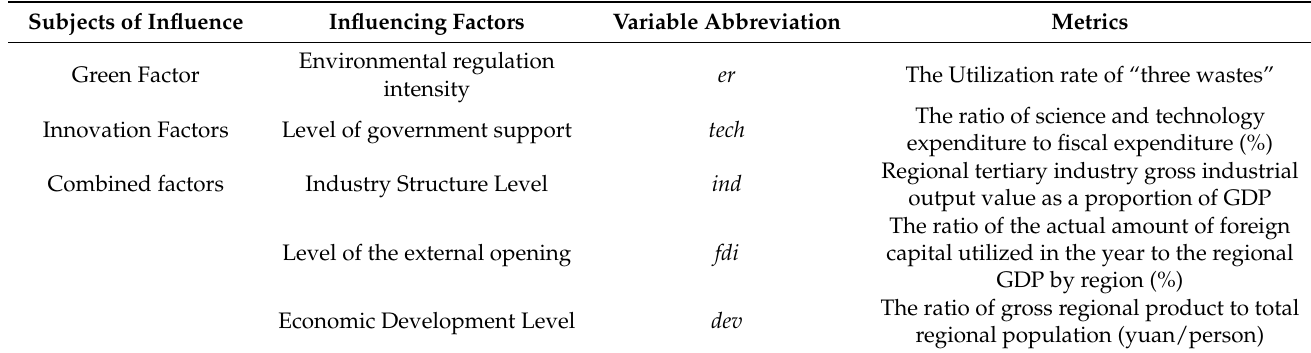
Table 6. Selection of indicators of influencing factors.